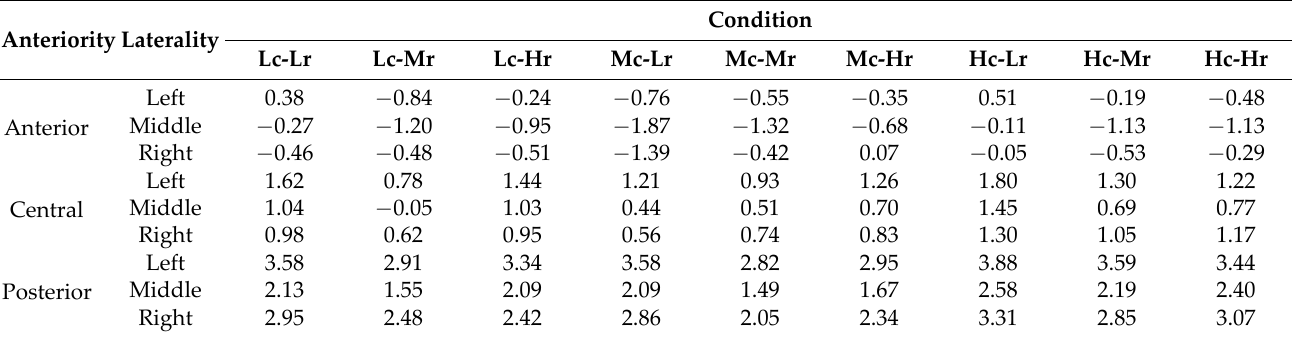
Table 3. Descriptive statistics of the LPP electrophysiological